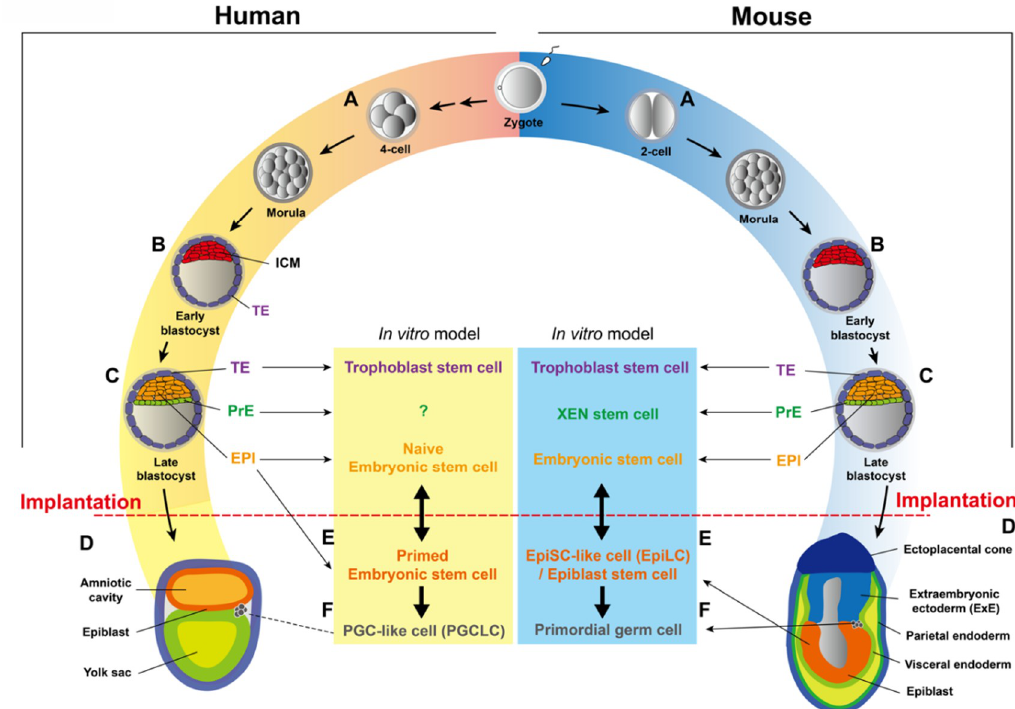
Figure 2. Progression of cell potencies in early embryos and cultured cells. The pre-implantation embryonic development starts with fertilized oocytes, followed by the zygotic gene activation at the 4-cell stage and 2-cell stage blastomeres in humans and mice, respectively ( A ). Zygotes and 2-/4-cell stage blastomeres are totipotent, forming the whole fetus, including embryonic and